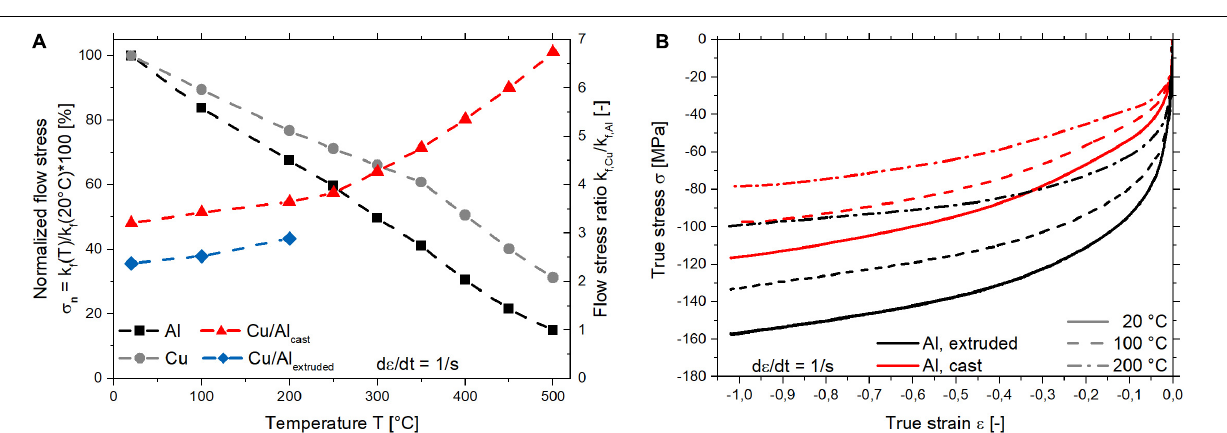
Figure 3A . An increase in the temperature to 350 and 500 ◦ C induces a reduction of the flow stress by 60 and 85% for aluminum as well as 40 and 70% for copper, respectively. This deviant development of flow stresses causes an increase in flow stress ratio from 3.2 at room temperature over 4.8 at 350 ◦ C to 6.7 at 500 ◦